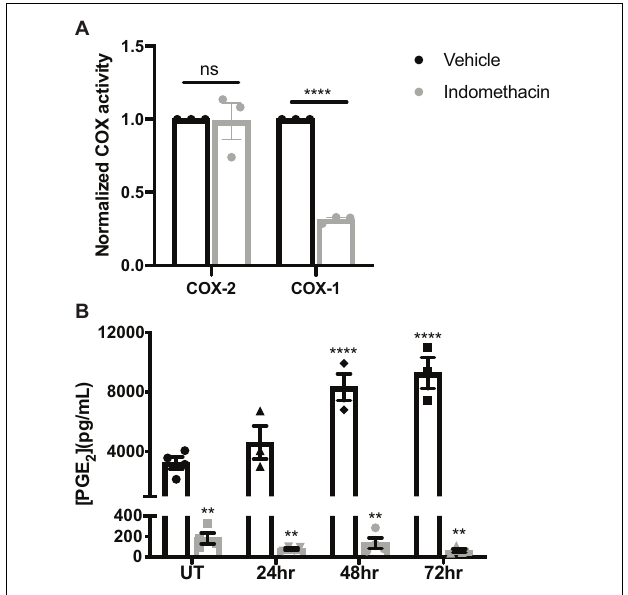
FIGURE 2 | Indomethacin treatment reduces cyclooxygenase-1 (COX) function and PGE 2 release in irradiated primary parotid acinar cells. Primary parotid acinar cells were prepared from C57BL/6J mice as described in section “Materials and Methods” and were untreated (UT) or treated with 5 Gy radiation (IR) with vehicle (Veh, saline with 0.1% ethanol) or indomethacin (Indo, 25 µ M) for 1 h prior to IR. (A) Untreated cells were collected after 24 h of indomethacin treatment, protein was extracted and COX activities were measured with a COX assay kit selective for COX-1 and COX-2. (B) Cell-free supernatants from vehicle or indomethacin treated cells were collected at indicated timepoints post-IR and PGE 2 secretion was measured with a PGE 2 enzyme-linked immunosorbent assay. (A,B) Graphs represent the mean ± SEM. Each symbol represents an independent sample. Significant differences from UT+ Veh treated cells were determined via (A) a student’s t -test or (B) a one-way ANOVA followed by Bonferroni’s post hoc comparisons (** p < 0.01, **** p < 0.0001; ns is not